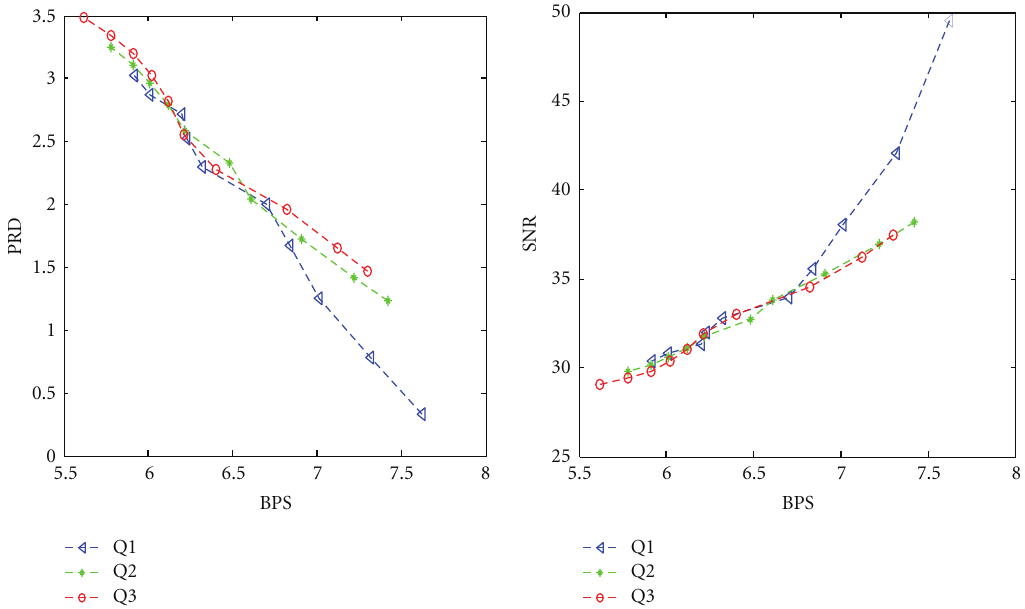
Figure 7: BPS versus PRD and BPS versus SNR characteristics using DS2.